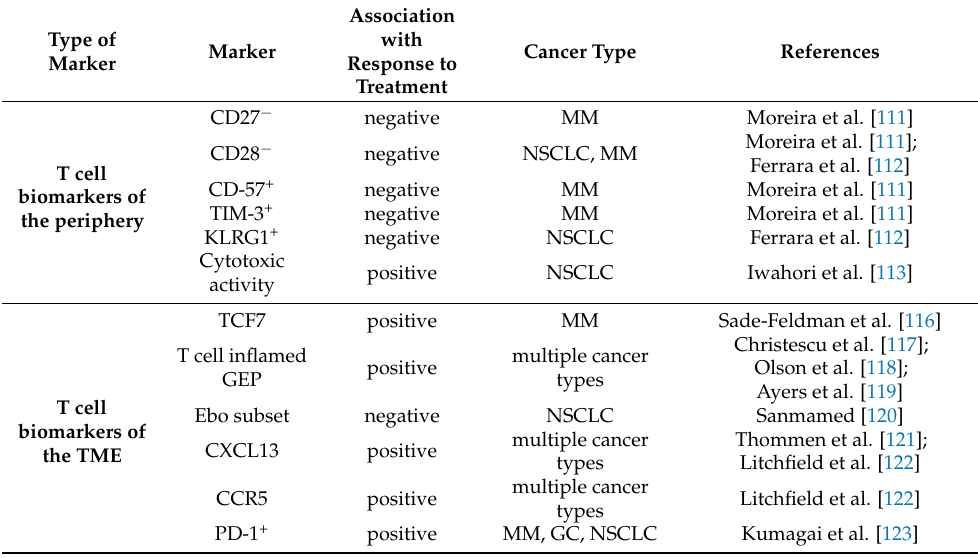
Table 1. Details of some factors of T cells that predict responses to immune checkpoint inhibitor therapy. MM (malignant melanoma), GC (gastric cancer), NSCLC (non-small lung cancer), burned- out CD8 + TIL (Ebo